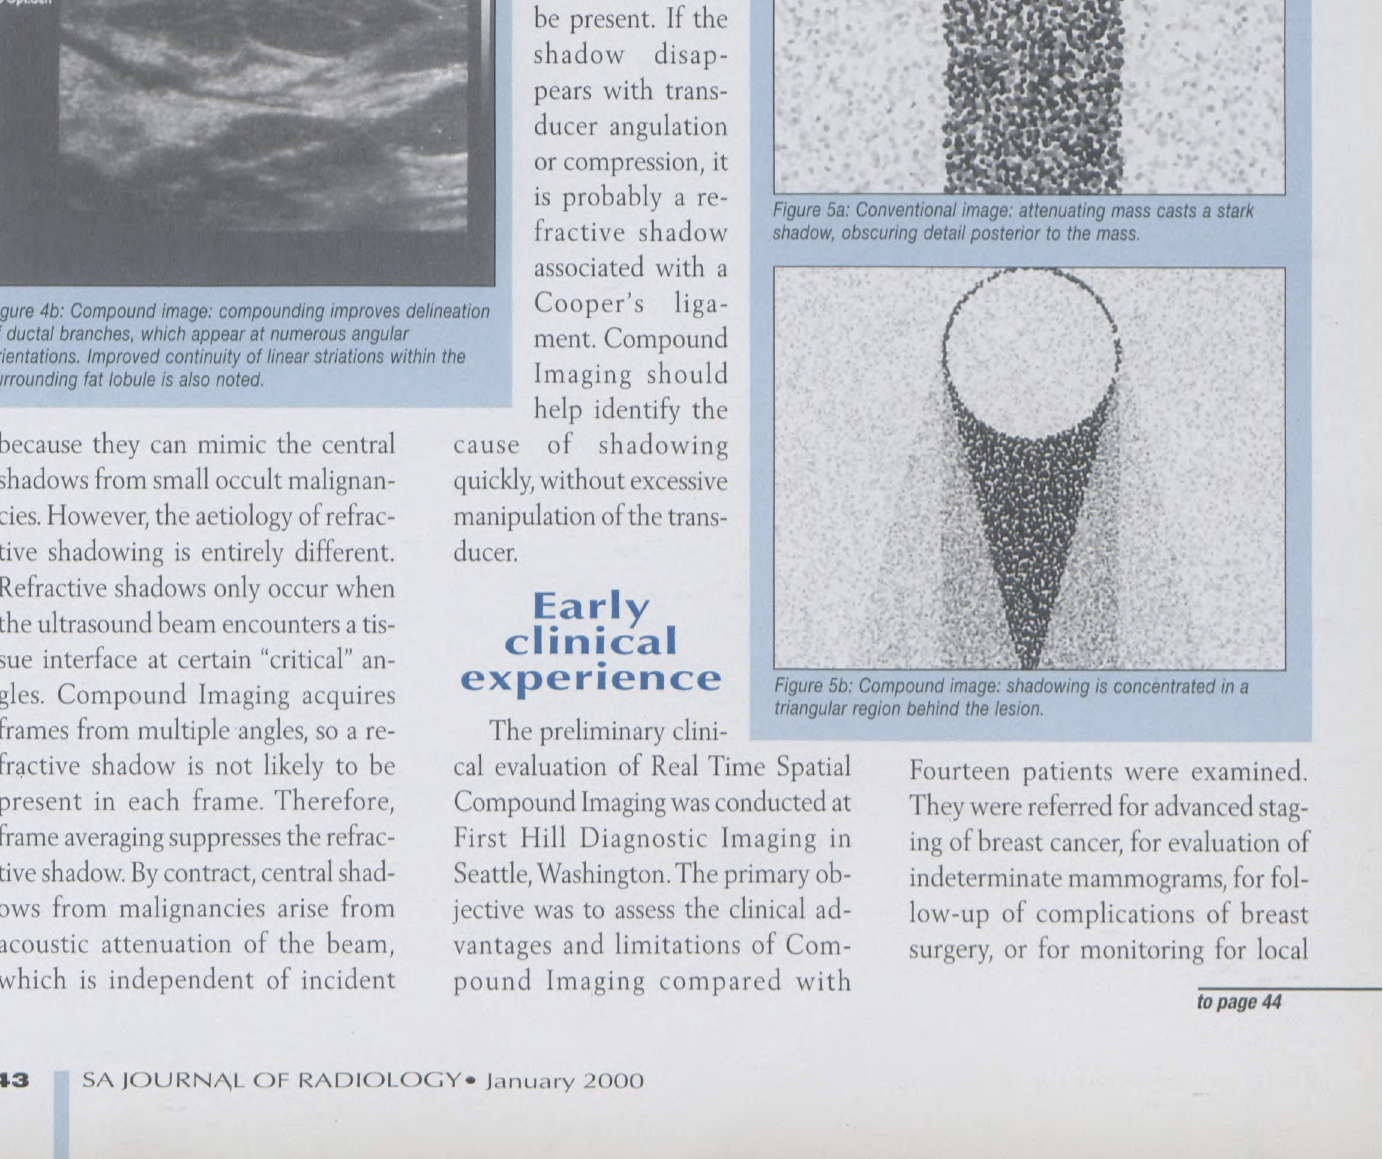
Figure 4a: Conventional image: normal breast with branching lactiferous ducts (arrow) in glandular tissue, with adjacent fat lobule. A variety of benign and malignant tumours can arise from or within the ductal structures of the breast.